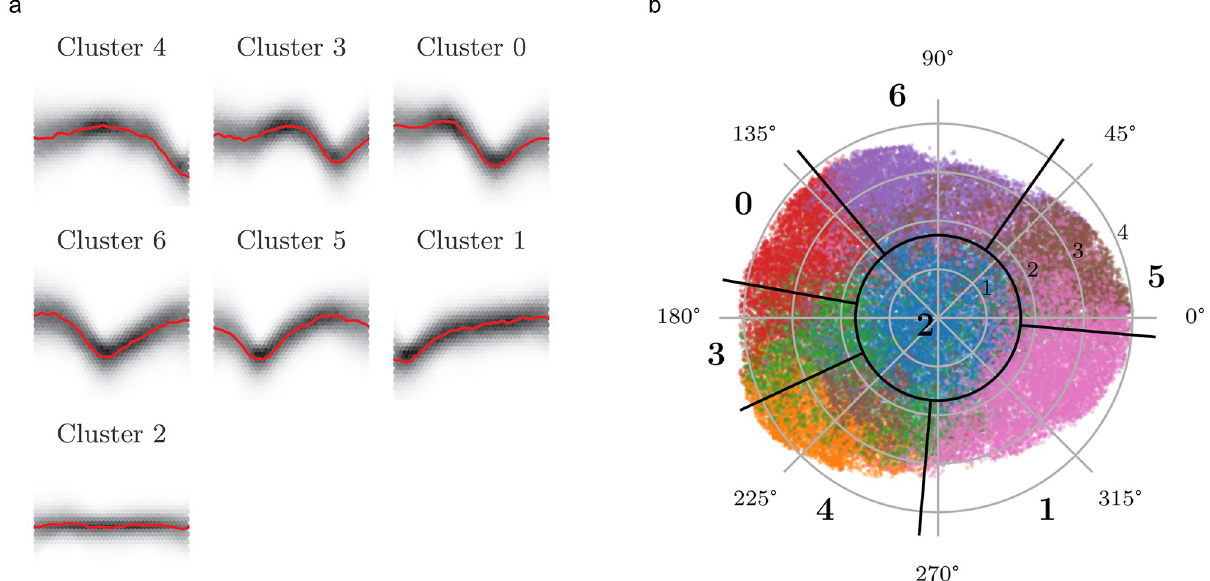
Fig 1. a Signal density and common signal of horizontal cells of the different clusters. All graphs have the same scale. The signals comprise 128 time steps, each time step being 40 μ s. The graphs are sorted in chronological order. The shaded areas show the density of data points, and the red line represents the approximated shape of the state based on a Nadaraya-Watson-estimator. b Dimension-reduced latent domain generated by the umap algorithm. The 2D umap values are mapped to polar coordinates with a center at x 1 = 4.95 and x 2 = 4.1. The colours represent the different clusters that were determined with the k-means algorithm. Radial black lines indicate the approximated borders of the clusters. The blue cluster in the centre ( 2 ) represents windows containing only noise. Starting with cluster 4 , the chronological order of the clusters in a is represented as a clockwise rotation. Axes with trivial, normalized or abstract values are not shown to increase the information value of the figures, as these axes do not provide usable information.